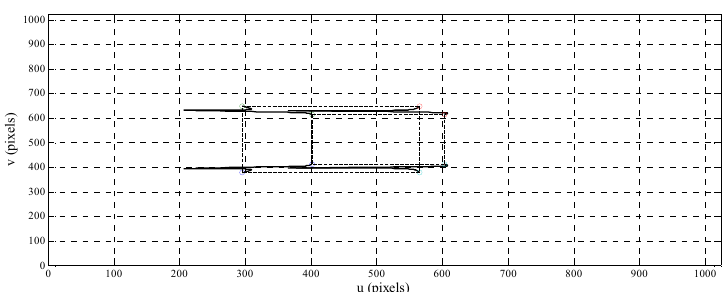
Figure 13. Case 1: Evolution of the robot trajectory in the image plane.